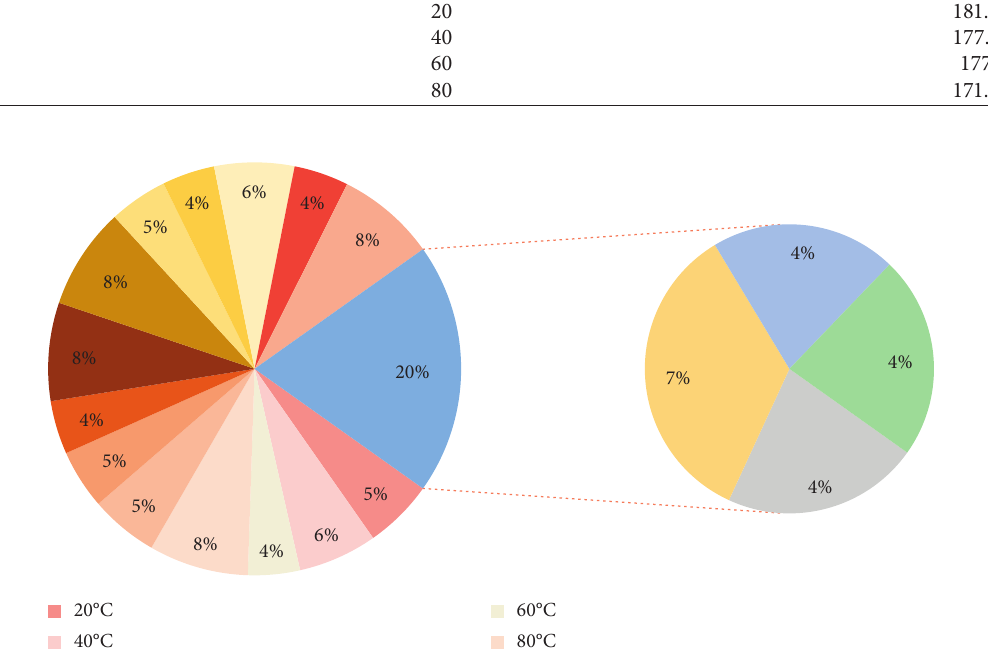
Figure 8: Changes of loading temperature and ultimate bearing